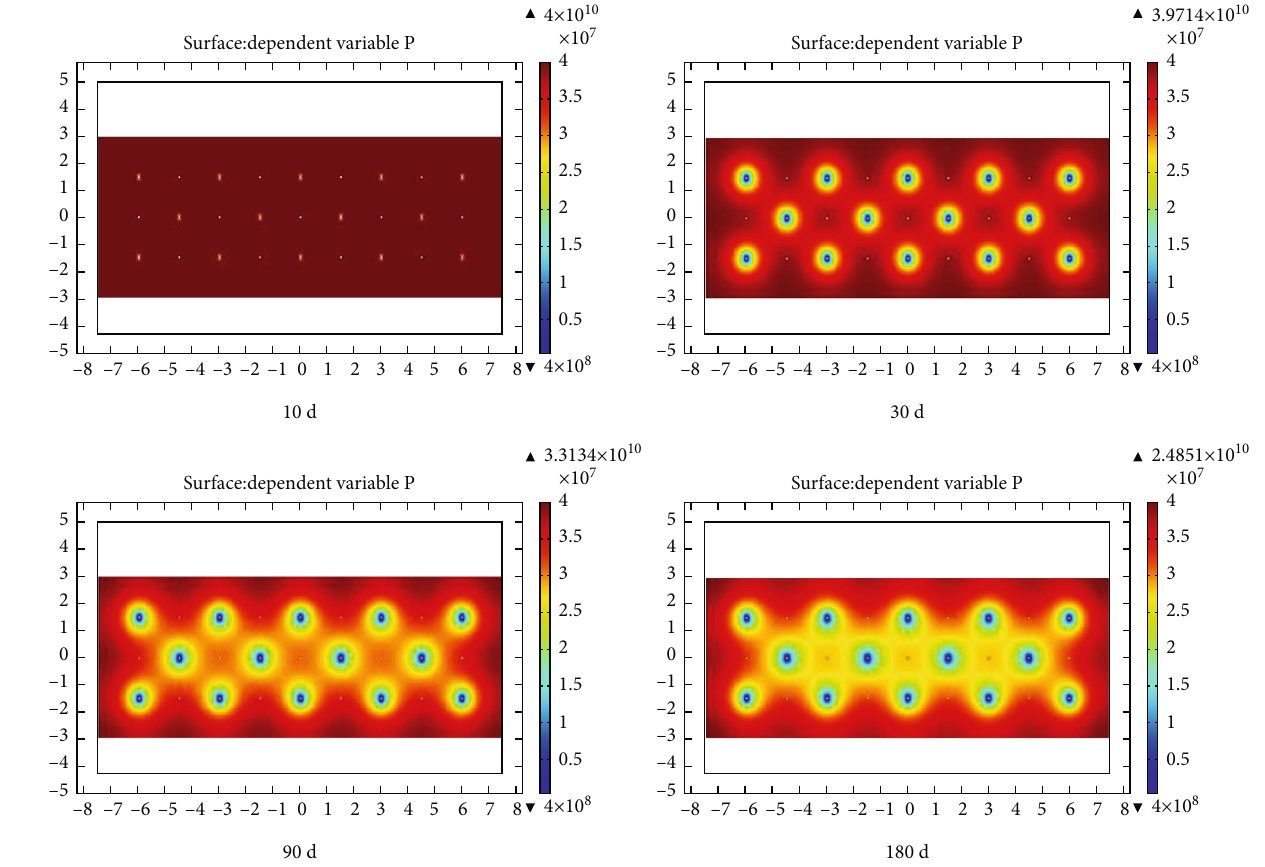
Figure 18: Gas pressure distribution map of mesh hole fracturing.